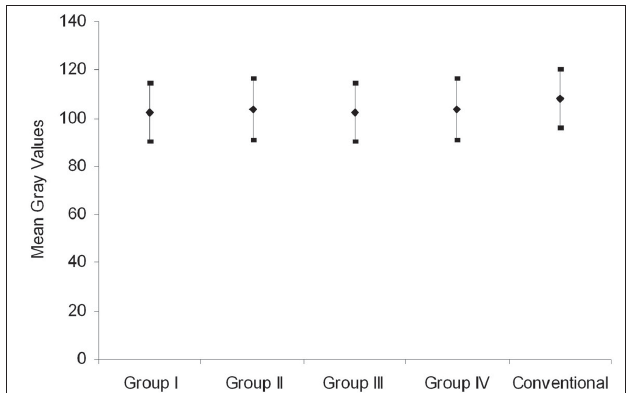
Fig. 2 – Comparison of mean gray values (± standard deviation) among all image groups.